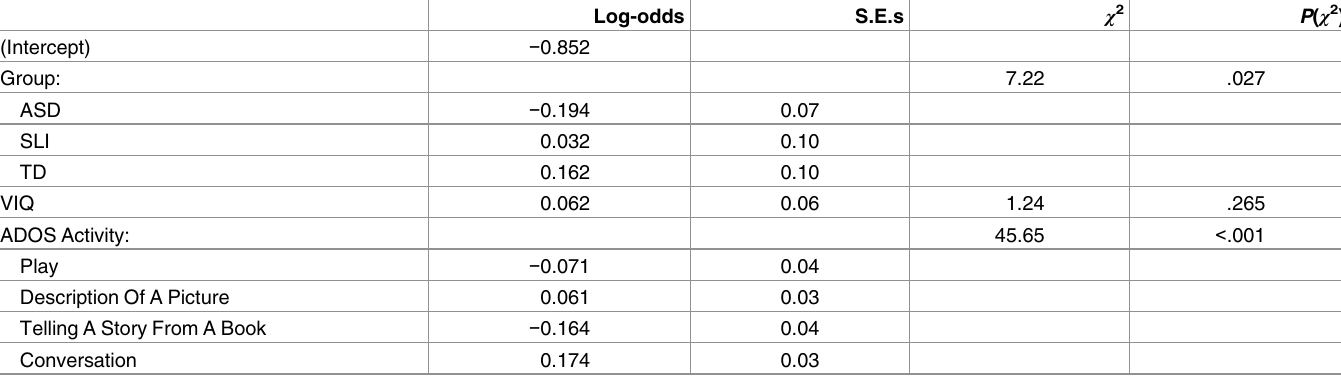
Table 7. Results for regression on cued versus non-cued content mazes.